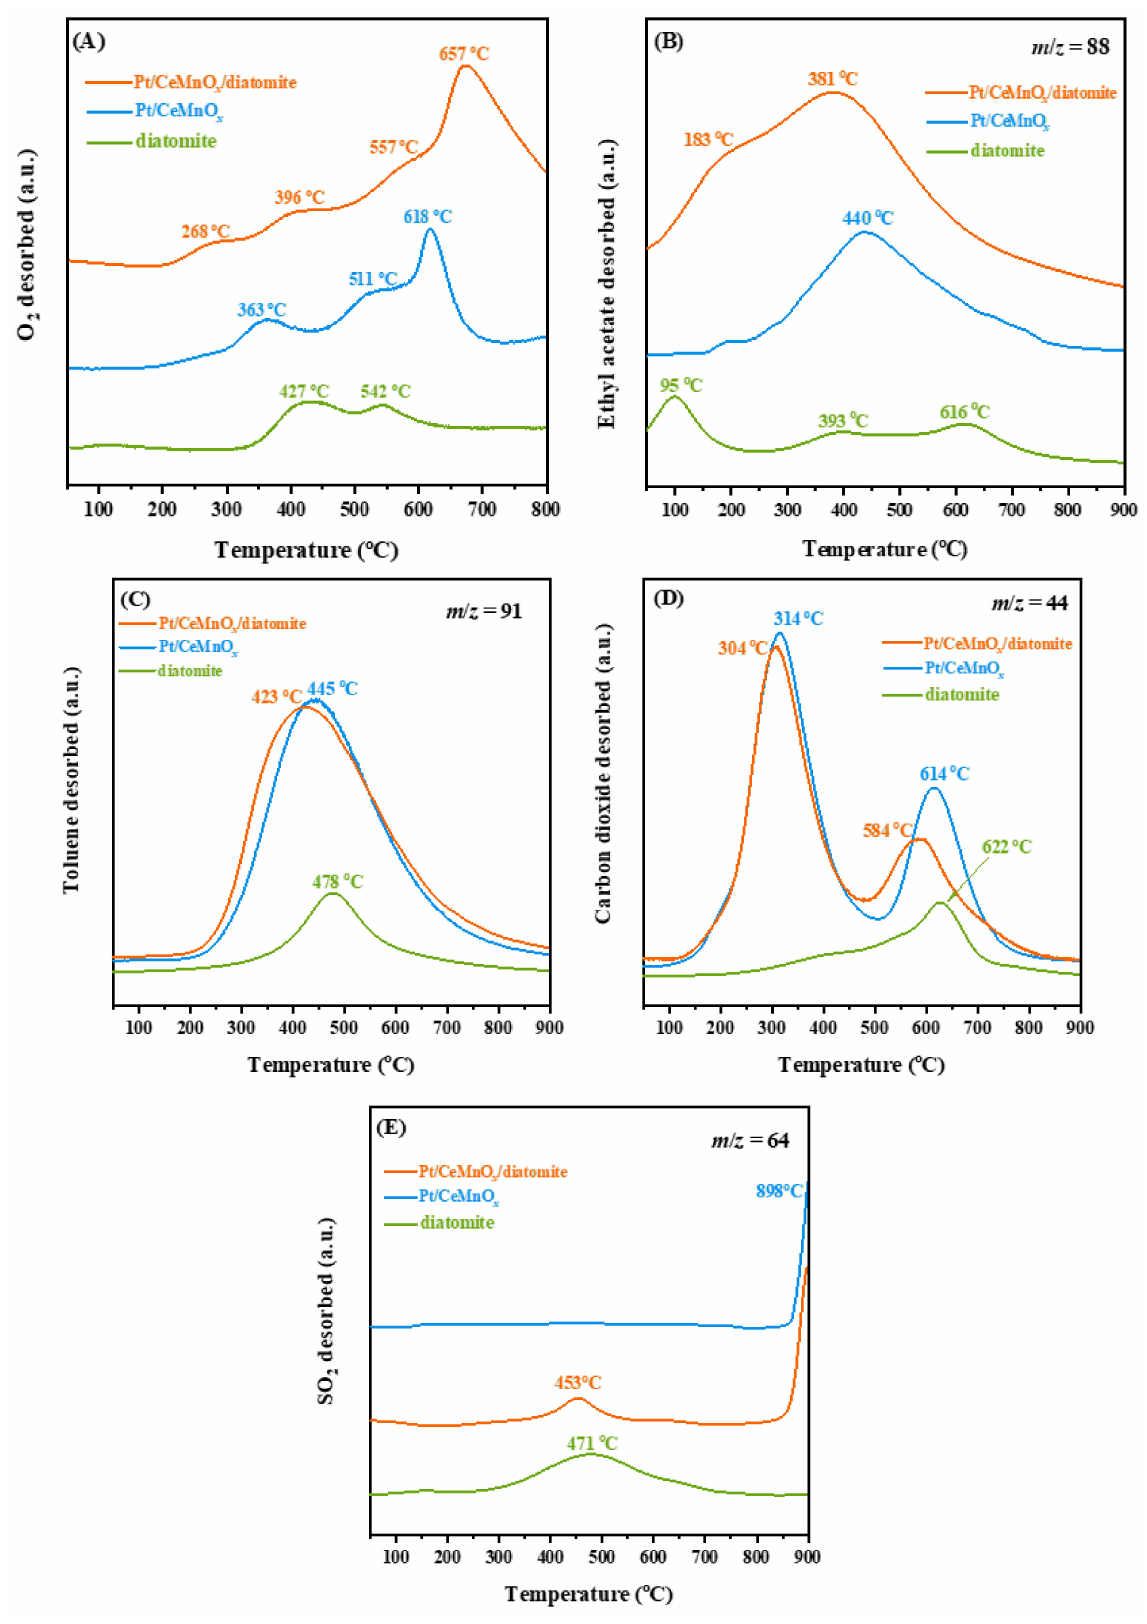
Figure 6. ( A ) O 2 -TPD, ( B – D ) (EA + toluene)-TPD, and ( E ) SO 2 -TPD profiles of the diatomite, Pt/CeMnO x /diatomite, and Pt/CeMnO x